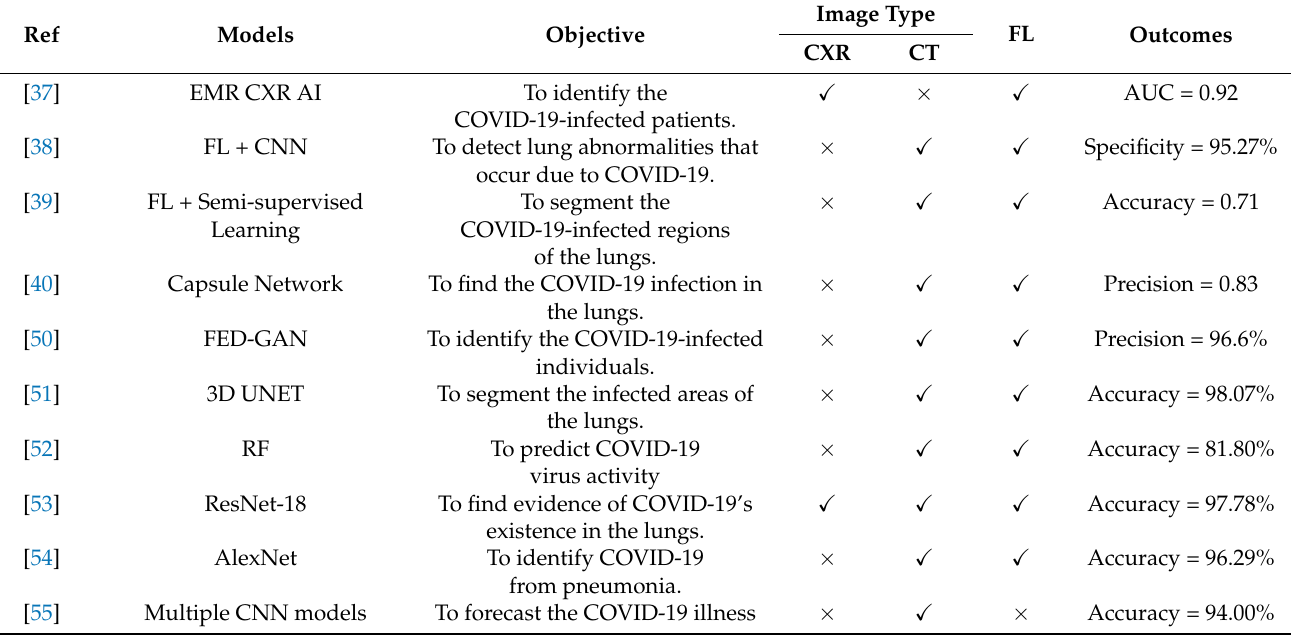
Table 1. Summary of related work for the identification of COVID-19 by using FL and DL